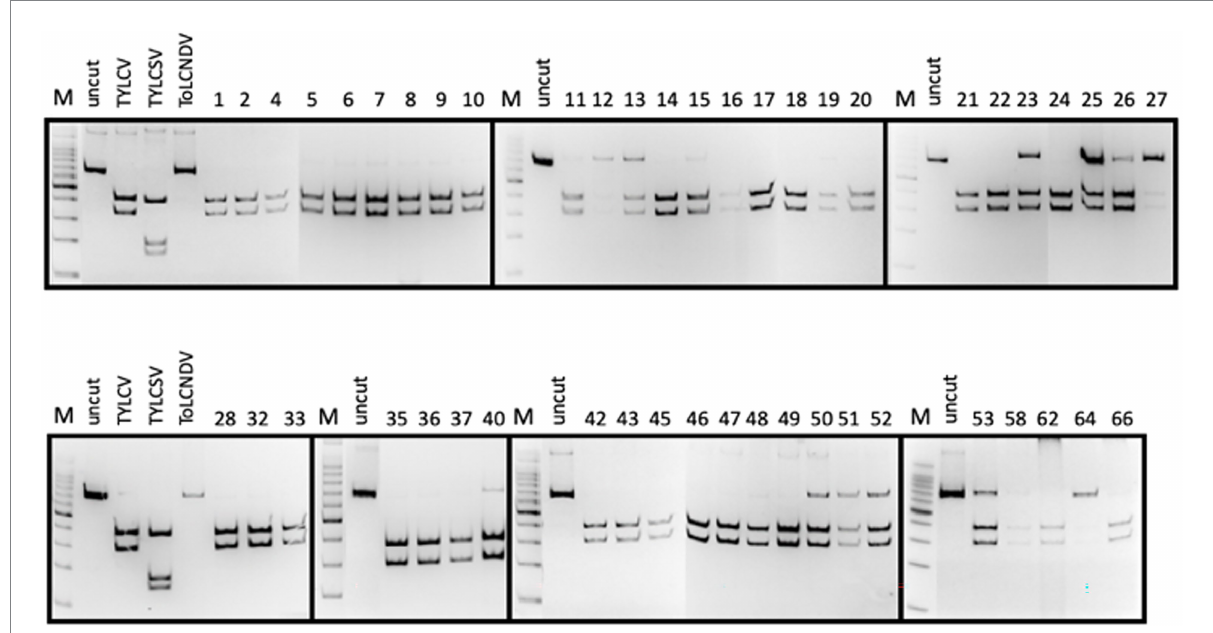
FIGURE 2 PCR-RFLP profiles obtained from each tomato plant sampled and checked for the presence of TYLC, TYLCSV, and ToLCNDV. The presence of viruses in samples showing weak fragments in acrylamide gels was further confirmed by specific qPCR (not shown).